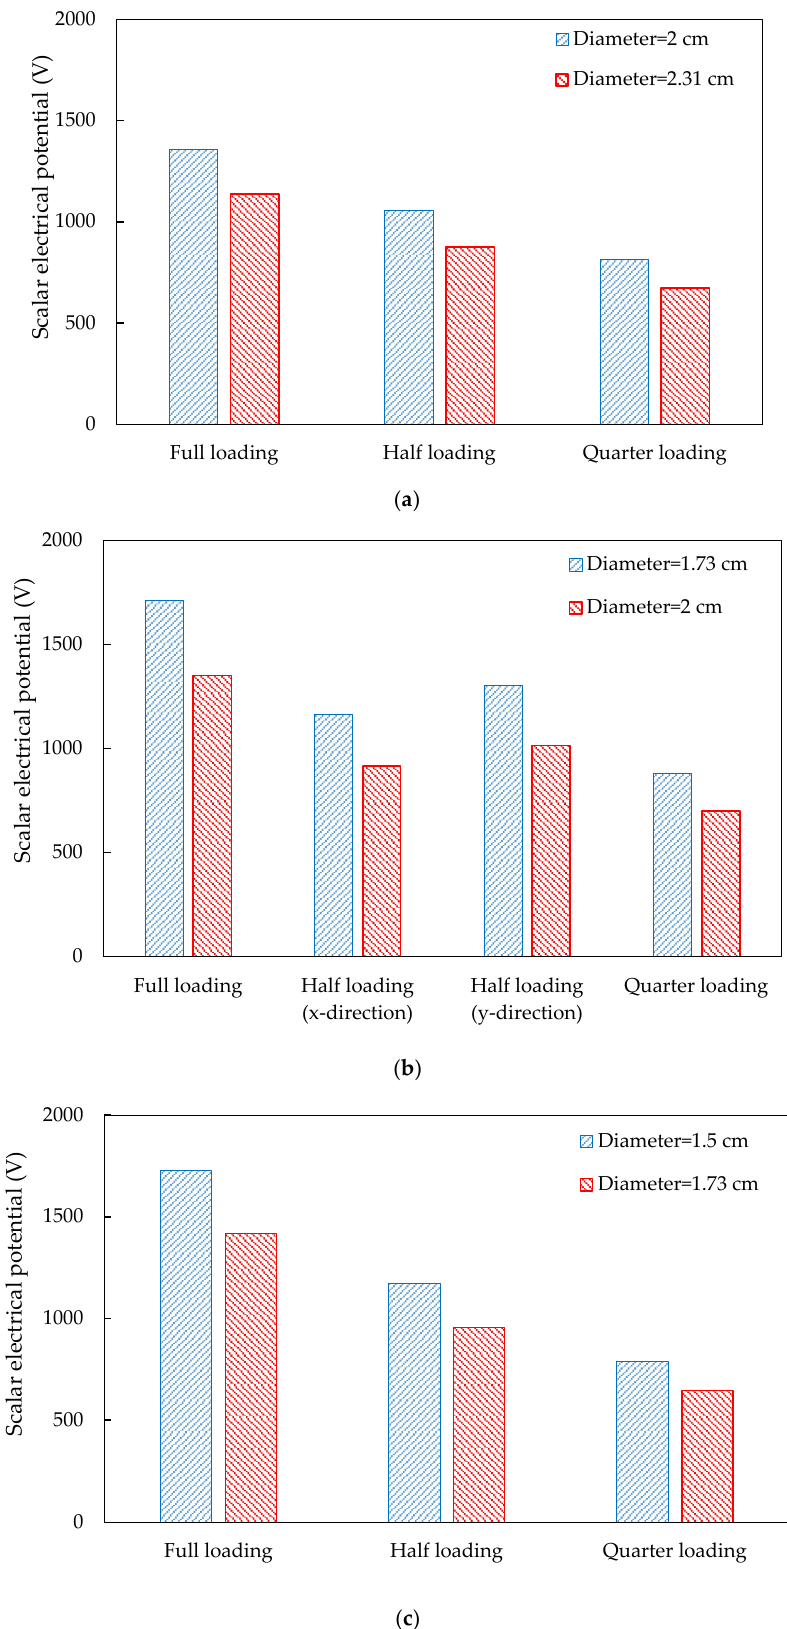
( b ) ( c ) Figure 12. Electrical potential distributions in piezoelectric units under quarter loading condition: ( a ) 3 × 3 with diameter = 2 cm; ( b ) 3 × 4 with diameter = 1.73 cm; ( c ) 4 × 4 with diameter = 1.5 cm.